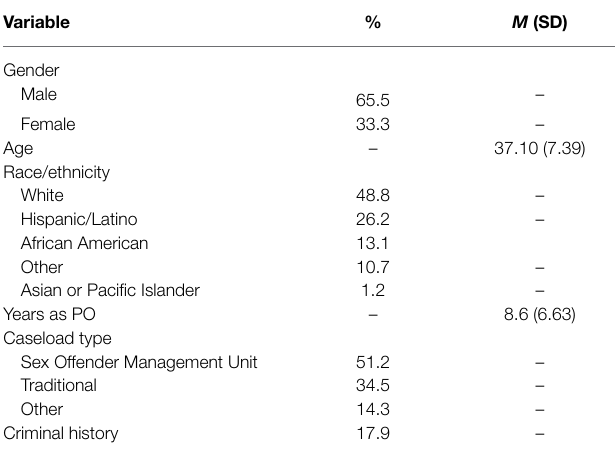
TABLE 1 | Demographics and characteristics of sample participants ( N =